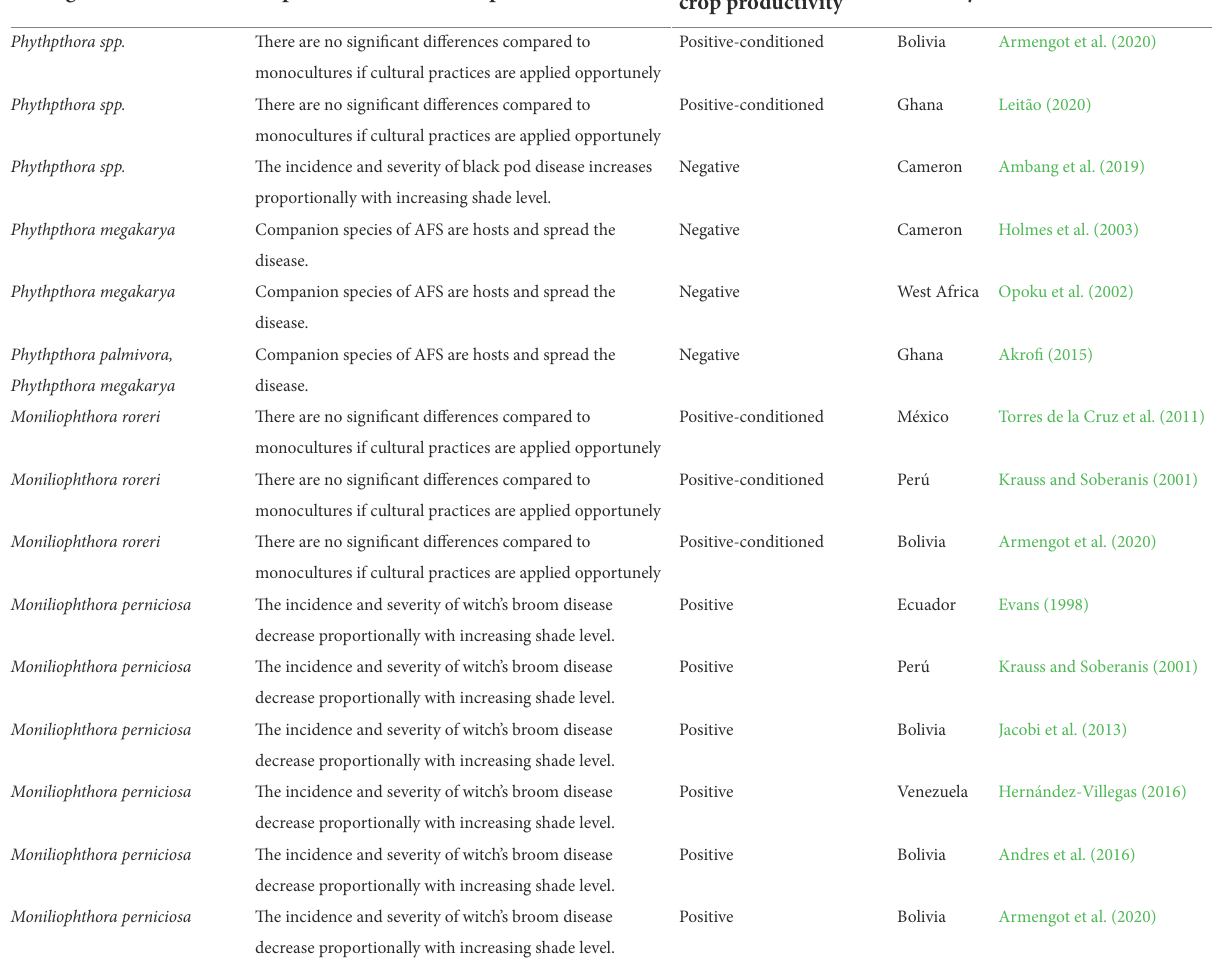
TABLE 1 Literature review on the use of agroforestry systems (AFS) in cocoa production, evidencing its effects on the incidence of diseases and potential impact on productivity.